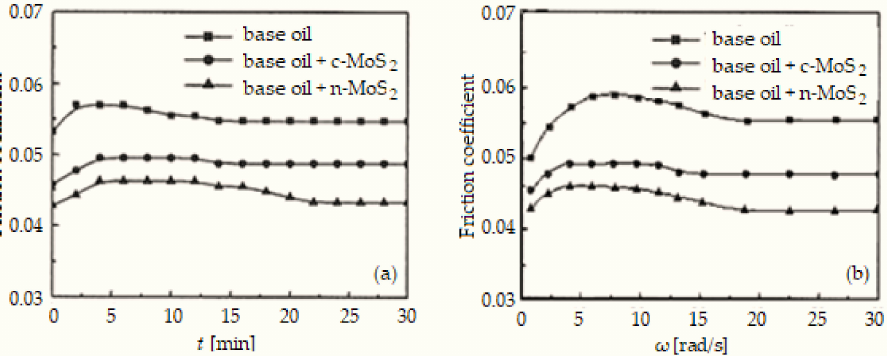
Figure 3. Friction coefficient variations depending on time, t ( a ) and angular sliding speed, ω ( b ) on a four-ball